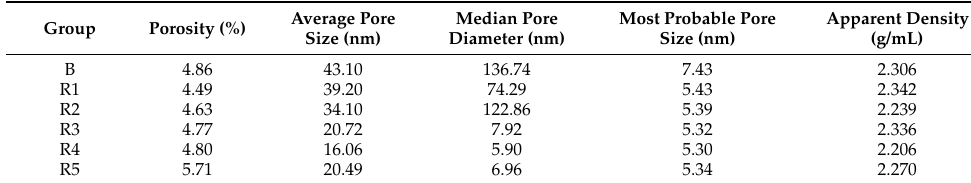
Table 10. The pore structure parameters of recycled brick powder UHPC with different substitution rates. Group Porosity (%) Average Pore Size (nm) Median Pore Diameter